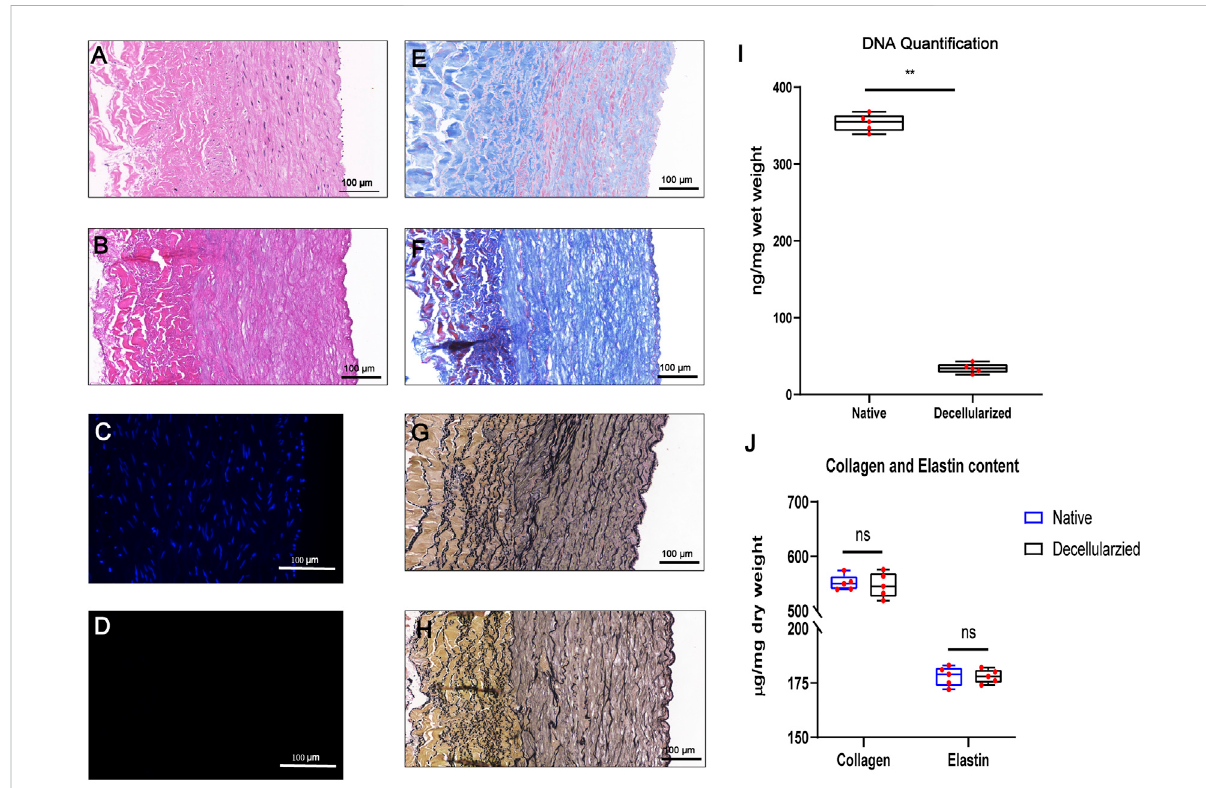
FIGURE 2 Successful decellularizationof bovine internal mammary artery (BIMA) whilepreserving extracellular matrix components. Characteristics of the bovine internal mammary artery (BIMA) before (A,C,E, and G) and after (B,D,F, and H) decellularization. H&E staining (A,B) , DAPI staining (C,D) Masson ’ strichromestaining (E,F) andelasticVan-Giesonstaining (G,H) .DNAquanti fi cationofnativeanddecellularizedBIMA (I) .Contentofcollagen and elastin was insigni fi cant between native and decellularized BIMA (J) . * p < 0.05. ** p < 0.01. ns represents no signi fi cant difference.